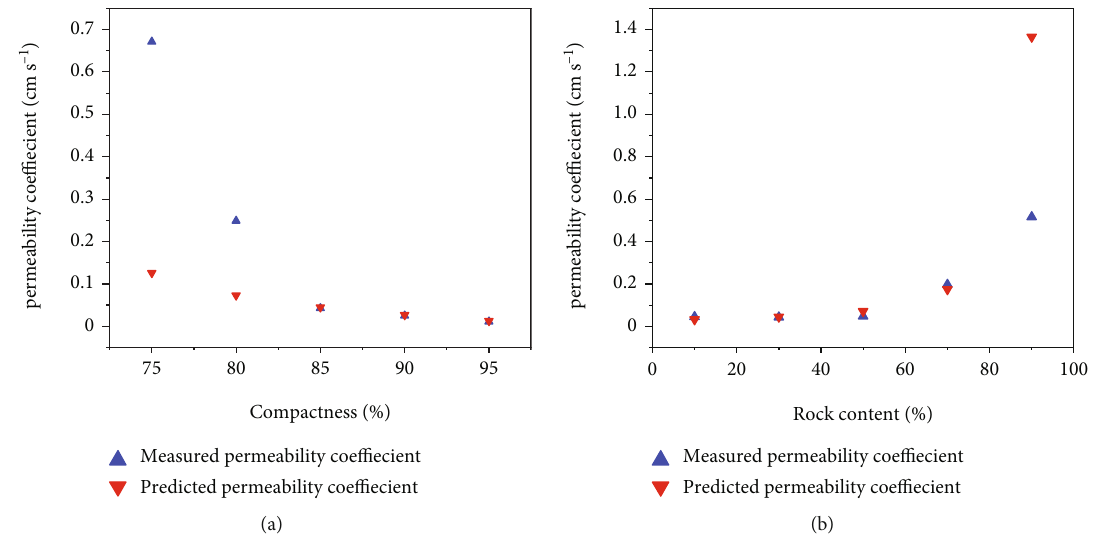
Figure 4: The permeability coe ffi cient with di ff erent compactness and di ff erent rock content. (a) Predicted and measured values of permeability coe ffi cient with di ff erent compactness. (b) Predicted and measured values of permeability coe ffi cient with di ff erent rock content.